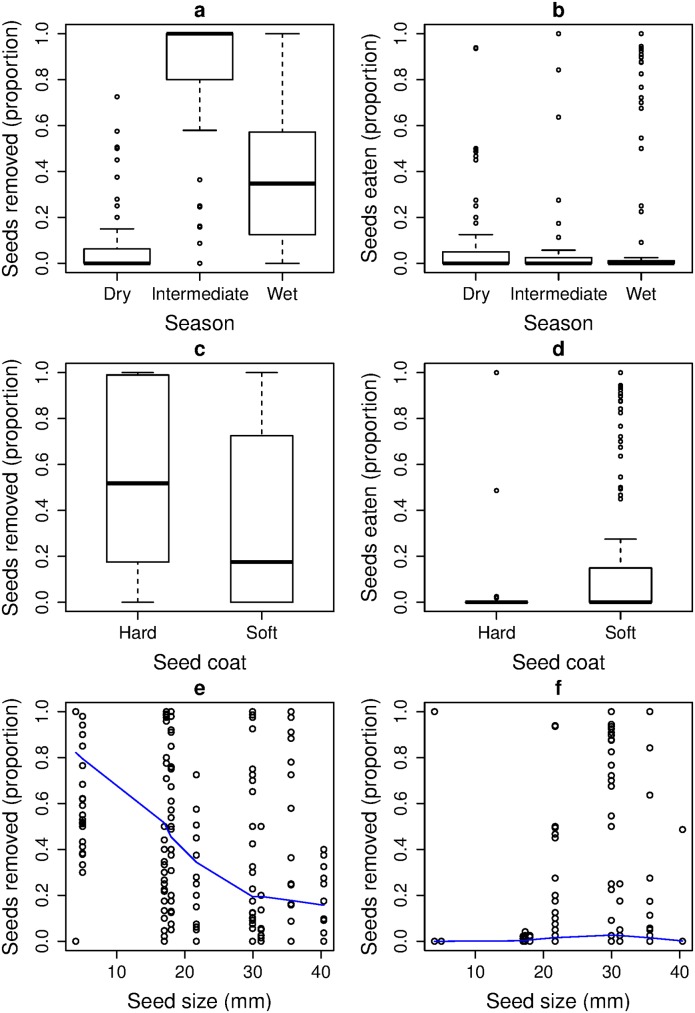
Patterns in seed handling by rodents.Relationship between proportion of seeds removed and proportion of seeds eaten or preyed upon with respect to season (a, b), and seed coat (c, d) using boxplots (median with the interquartile range and the whiskers representing data ranges) and with respect to seed size (e, f) using scatterplots and fitting the line with locally weighted scatterplot smoothing (LOWESS).